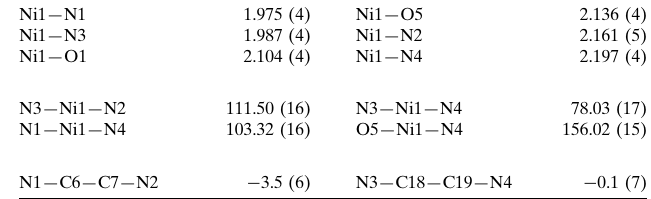
Selected geometric parameters (A˚ , (cid:2) ).